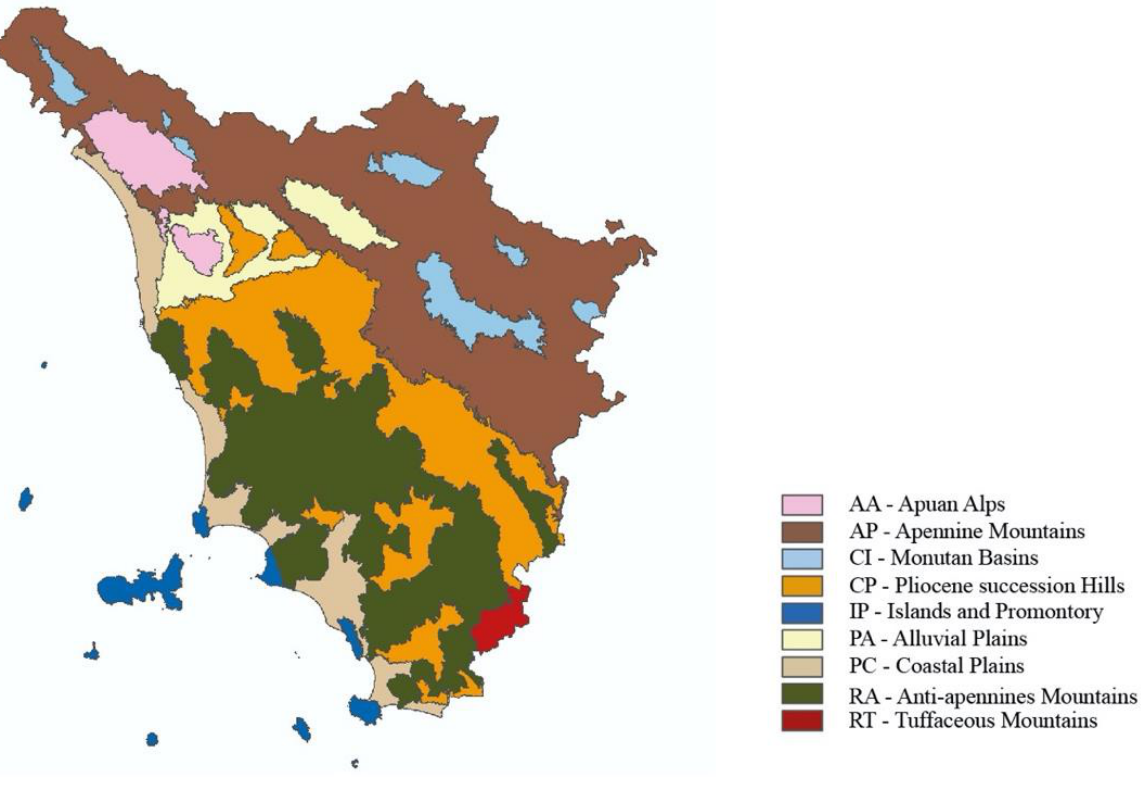
Figure 3. Landscape System according to Rossi et al. 1994 The division in Landscape System was used to calculate the supply capacity of ES of the different parts of the Tuscan